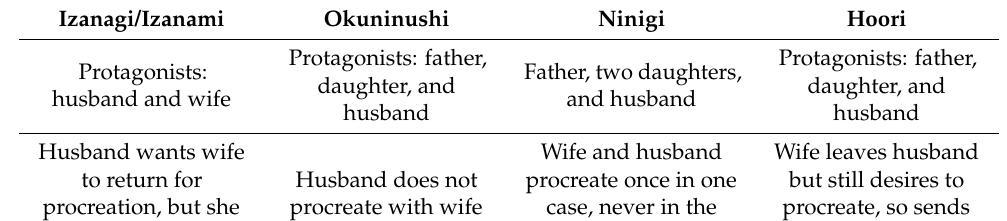
Table 2. Comparisons of Myths 1, 3, 4,